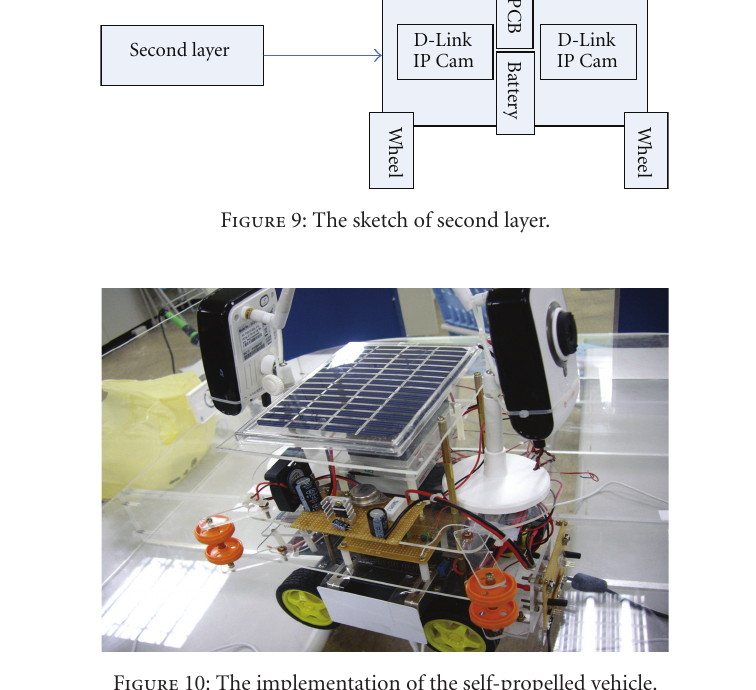
Figure 10: The implementation of the self-propelled vehicle.